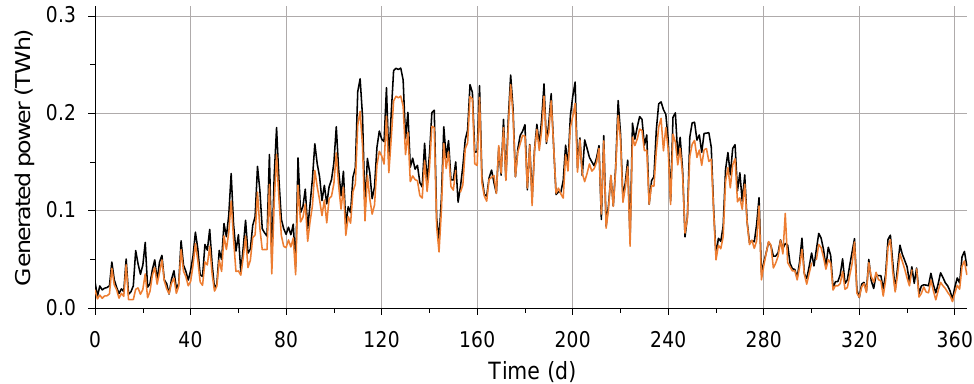
Figure 4. Simulated power generation (black line) and measured feed-in data (orange line) from PV systems in Germany for 2016 with a daily resolution.